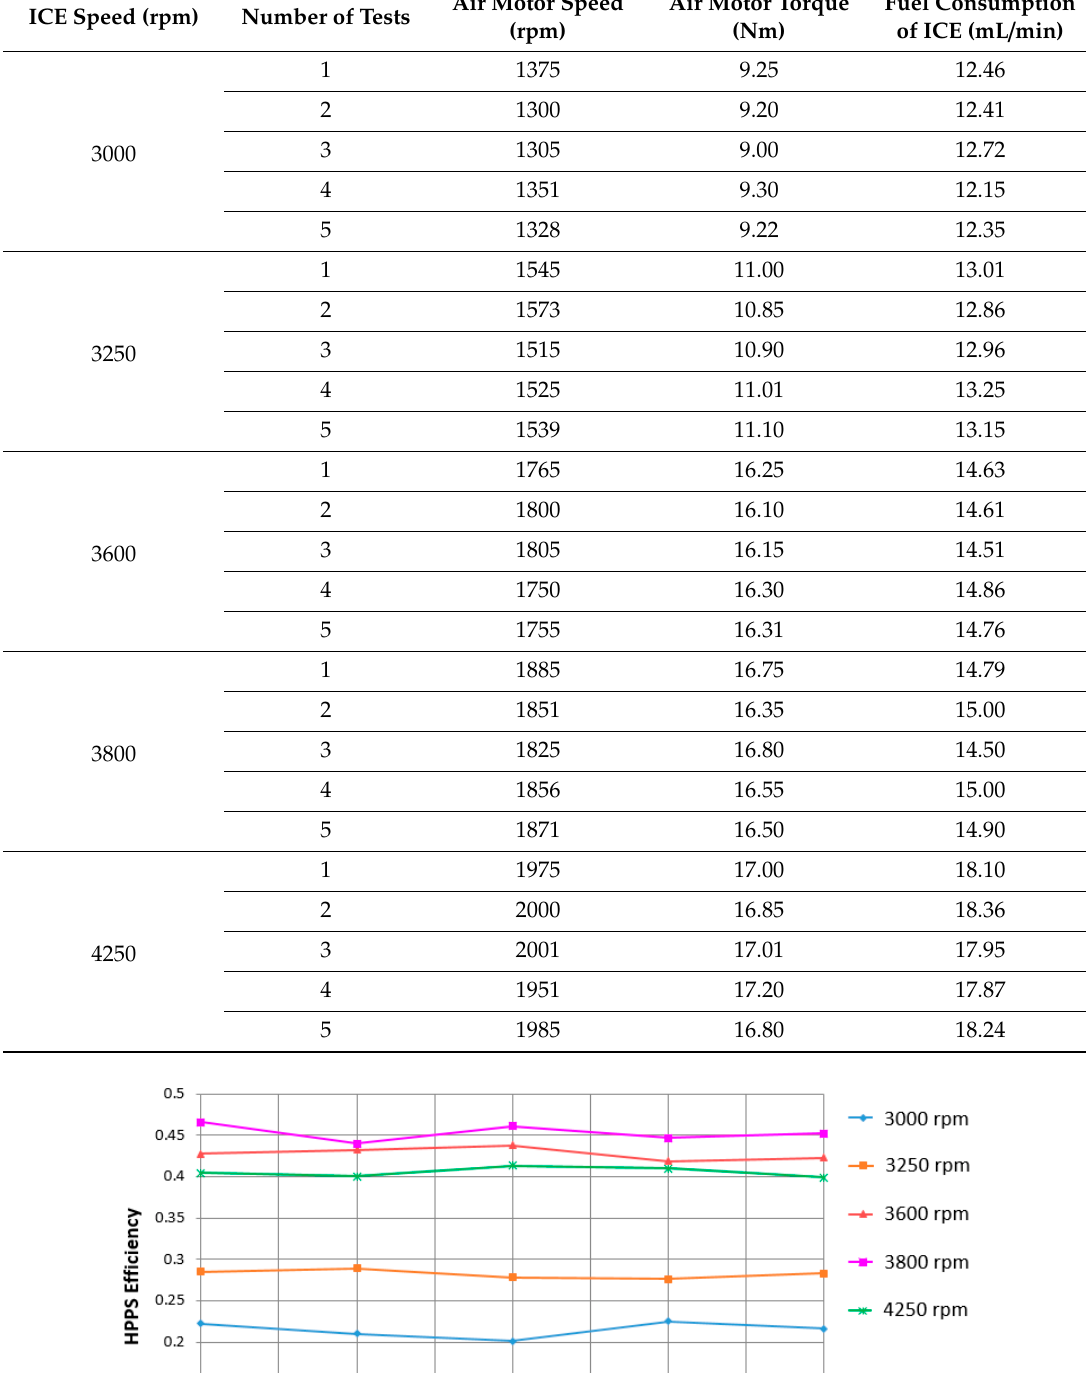
Table 1. Input and output specifications of HPPS.